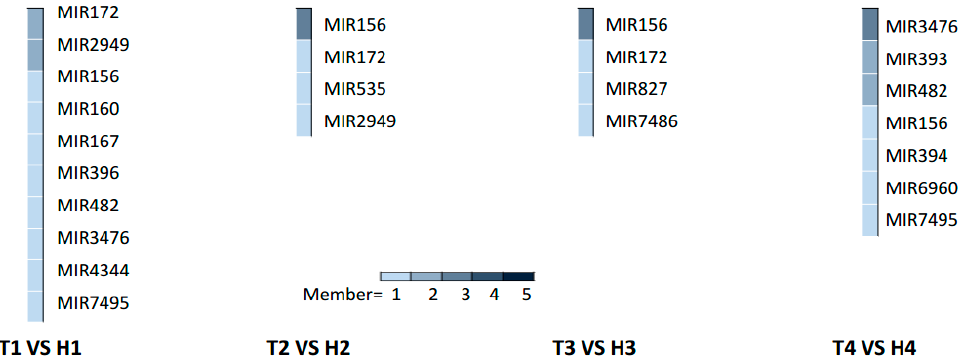
Figure 3. Anther stage-specific miRNA families responding to HT stress in the HT-tolerant and the HT-sensitive lines.